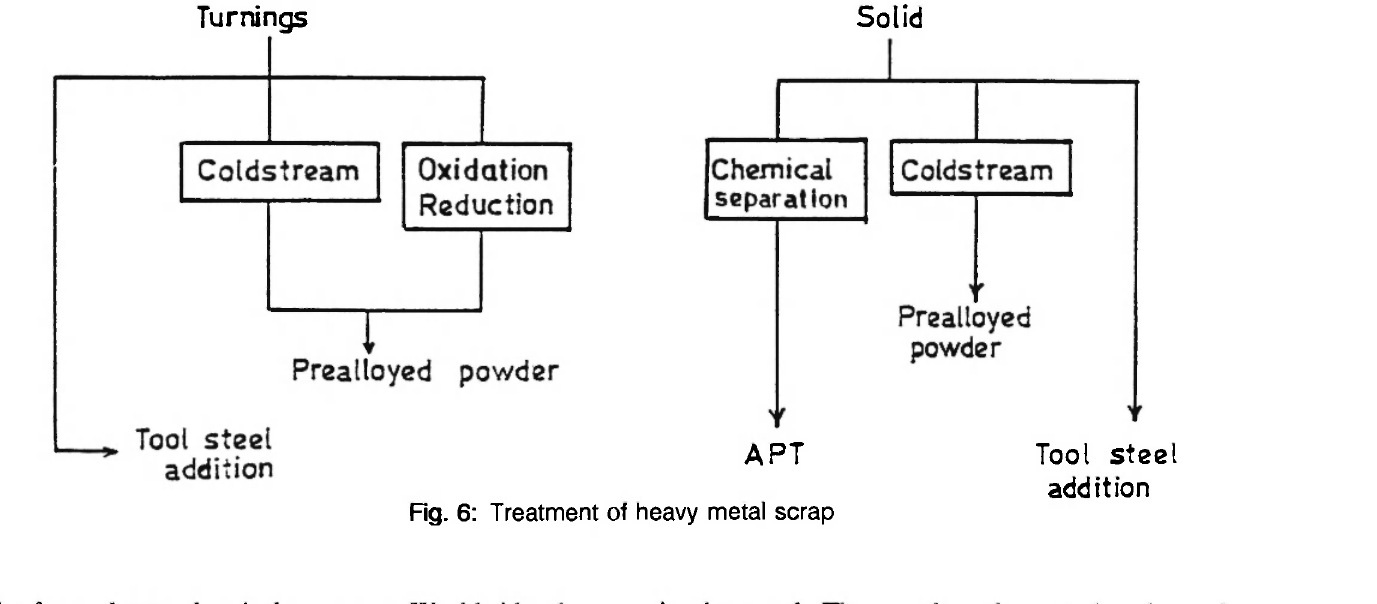
is also used. The powders thus produced can be directly recycled into the mainstream with a minor carbon adjustment to account for the increased oxygen content of such reclaimed powders. Figure 7 gives a summary of the physical and chemical